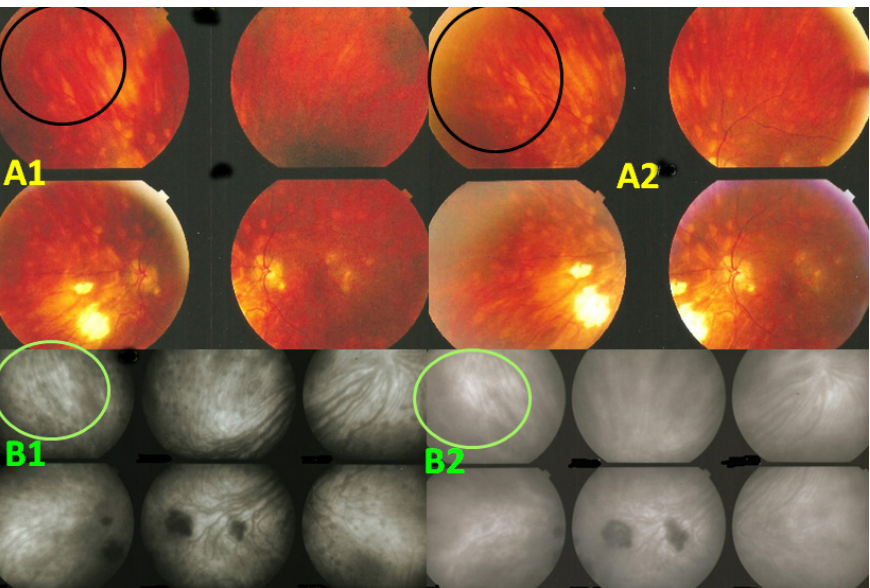
Figure 12. Indocyanine green angiography (ICGA) lesions do not correspond to birdshot retinochoroiditis (BRC) fundus lesions. This man was 68 years old at presentation; his history featured a 32-month diagnostic delay and a 38-month treatment delay (left eye). Fundus images before treatment ( A1 , left quartet of fundus images) reveal well-delineated BRC fundus lesions, as well as whitish chorioretinal scars, inferior-nasally. After 3 years of inflammation suppressive treatment (IST), the fundus aspect exhibited absolutely no change ( A2 , right quartet). ICGA frames reveal numerous typical hypofluorescent dark dots (HDDs), as well as a larger hypofluorescent chorioretinal atrophic scar temporal to the fovea, before treatment ( B1 , left 6 frames). Three years after IST, HDDs had disappeared and chorioretinal atrophy exhibited the same geographic hypofluorescent area ( B2 , right 6 frames). This example demonstrates that HDDs do not correspond to BRC fundus lesions, which are angiographically silent and do not respond to treatment as they are choroidal scars .